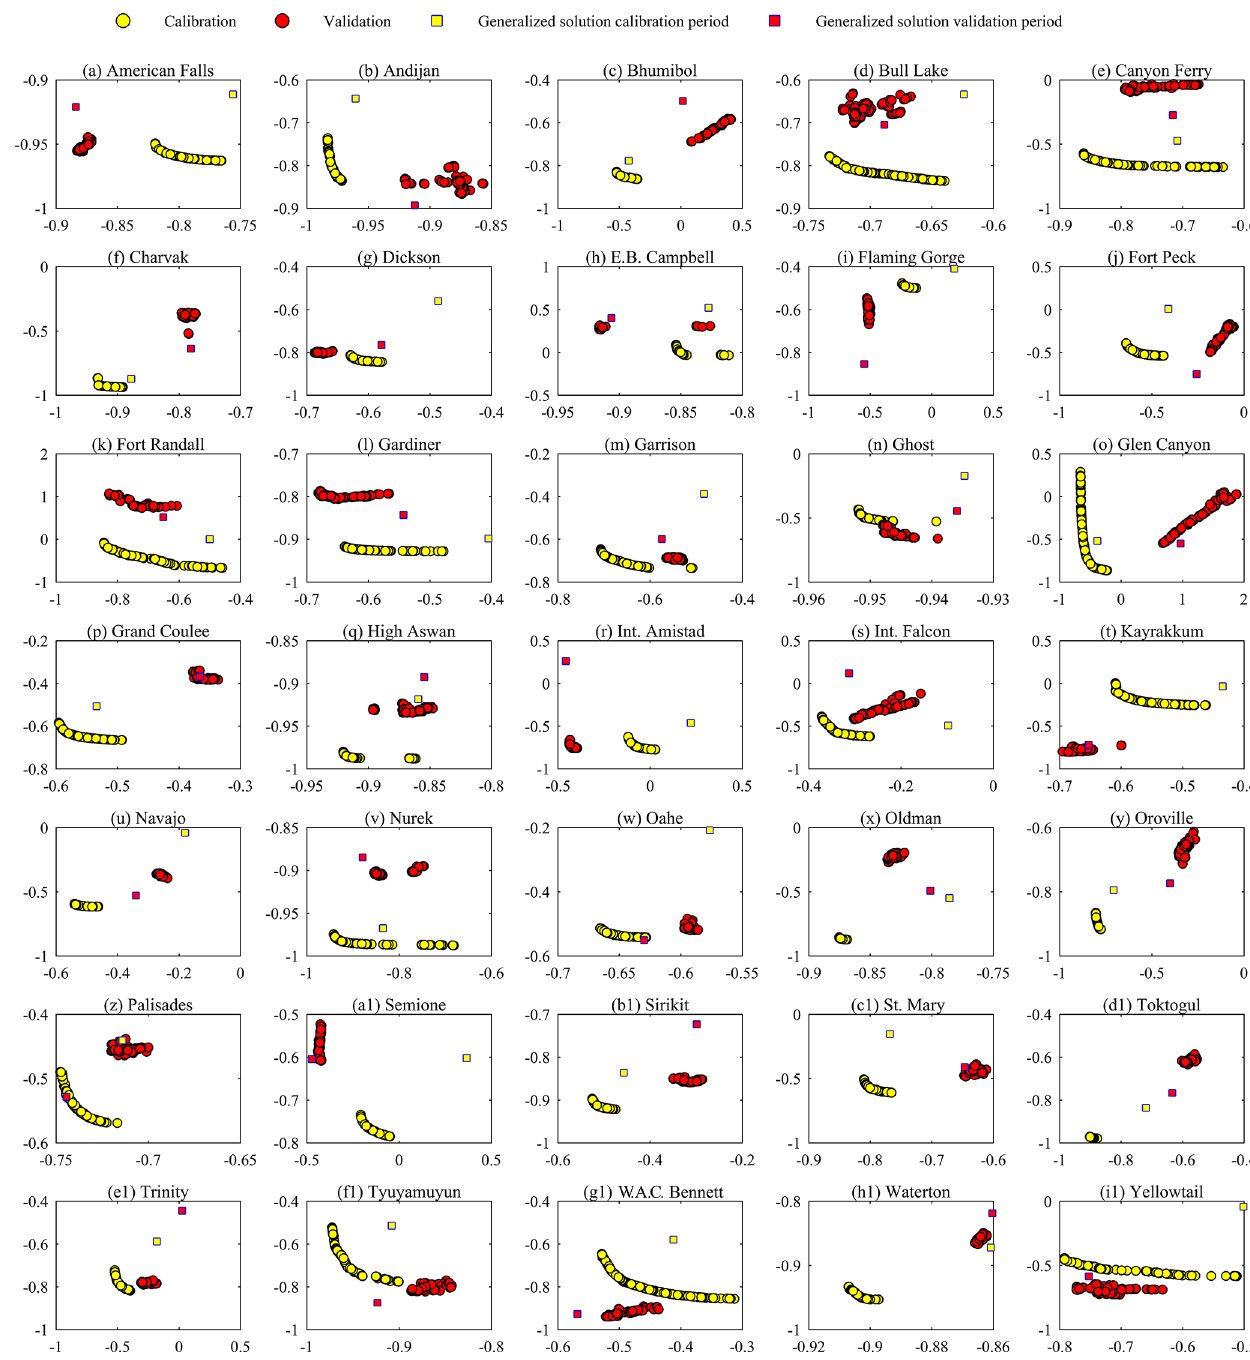
Figure 11. Reservoir-release-parameter multi-objective calibration result. x axes show NSE (flow) multiplied by − 1, and the y axes show NSE (storage) multiplied by −